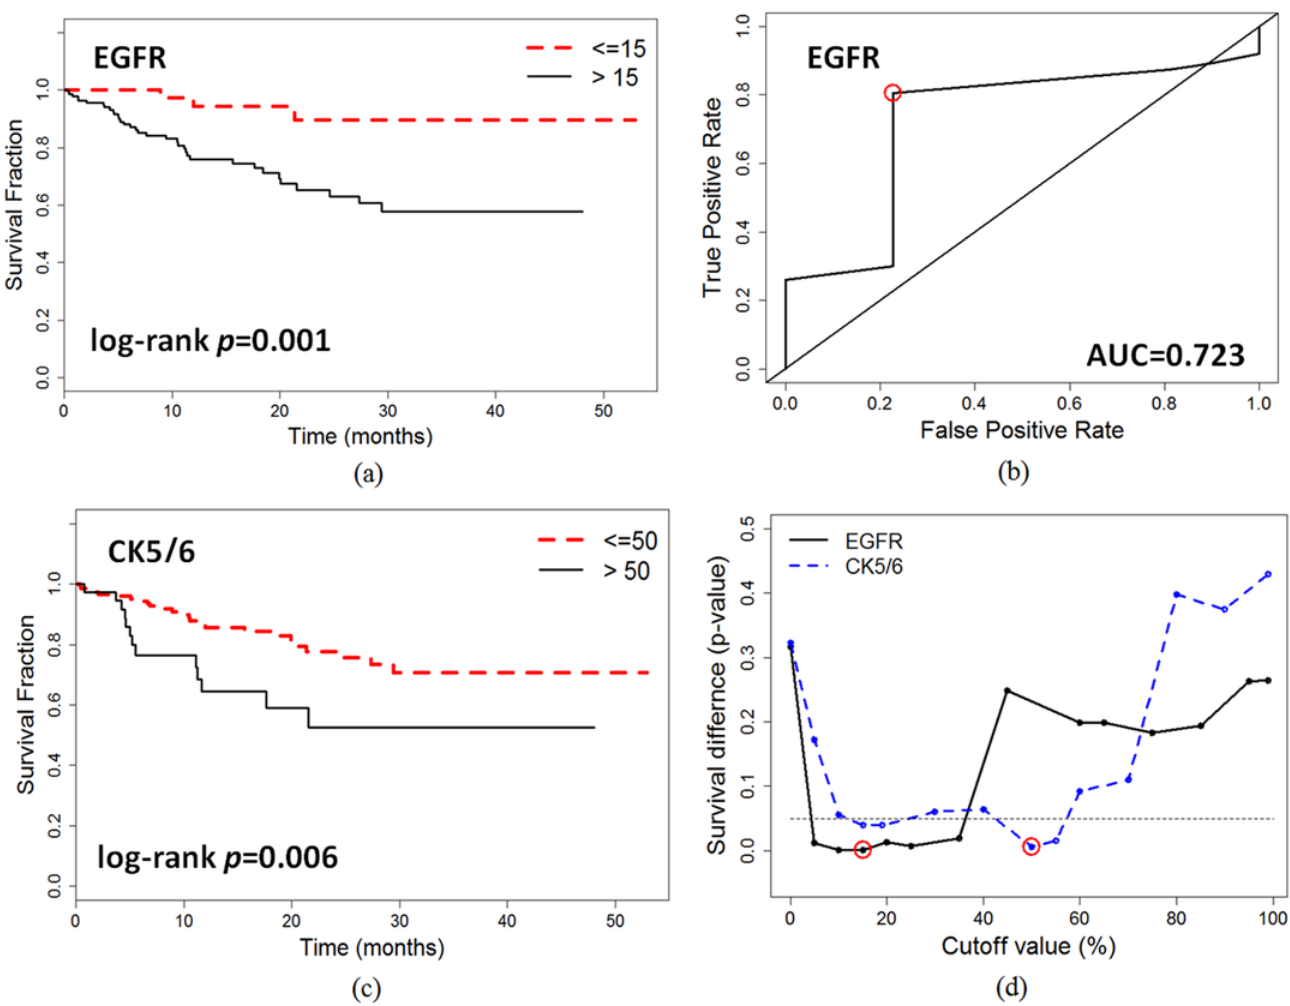
Fig 2. Kaplan Meier curves of disease free survival for basal biomarkers. (a) EGFR at cut-off level 15% with log-rank p = 0.0016, (b) time-dependent ROC analysis of EGFR with AUC = 0.723, where cutoff point 15% (red circled), (c) CK5/6 at cut-off level 50% with log-rank p = 0.0066, and (d) the significance of survival difference at different cutoff values for EGFR and CK5/6. The most significant cutoff values were red-circled with 15% for EGFR and 50% for